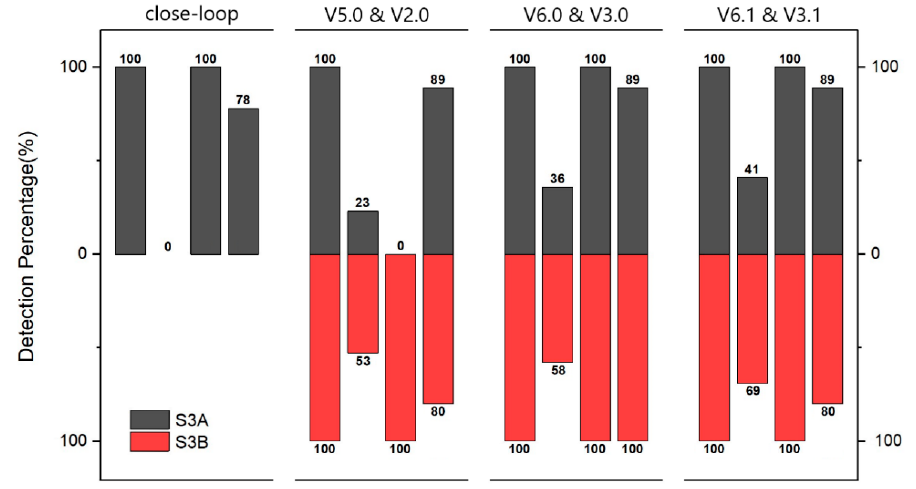
Figure 7. Comparison of the detection rates of Sentinel-3A (S3A) and Sentinel-3B (S3B) at different stages. The bars of each stage from left to right are the detection rate in the high elevation and wide river (HW), high elevation and narrow river (HN), low elevation and wide river (LW), and low elevation and narrow river (LN), respectively.